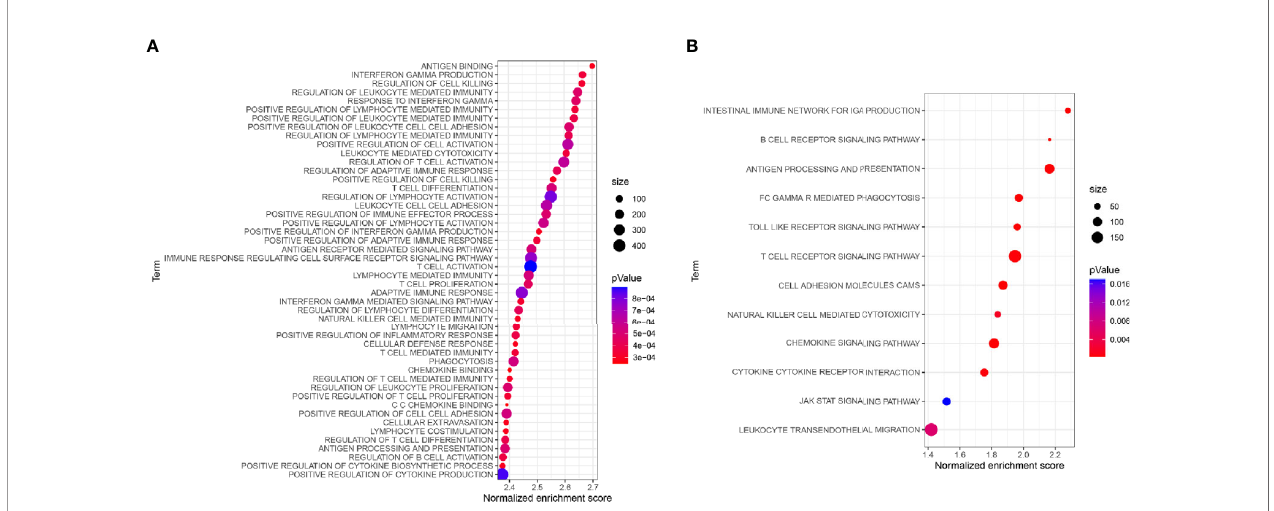
FIGURE 5 | (A) GO-related GSEA between different risk groups. (B) Functional enrichment analysis of KEGG for key